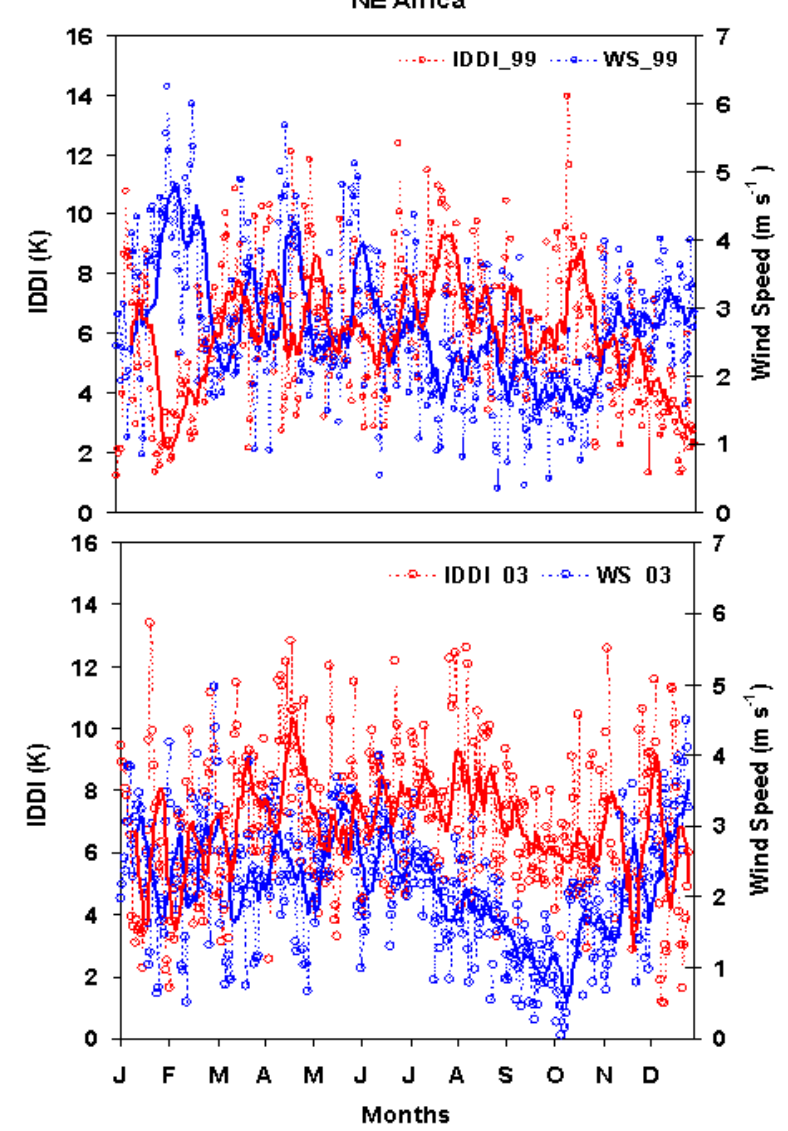
Fig. 5. Daily IDDI and wind speed (dashed lines) for NE Africa. Solid line represents 10-day running average. Prospero, 1987; Nickling and Gillies, 1989). The slope (lin- ear fit) for 1999 (and 2003) for Saudi Arabia-I was 0.88 (1.4) and that for Rajasthan was 1.1